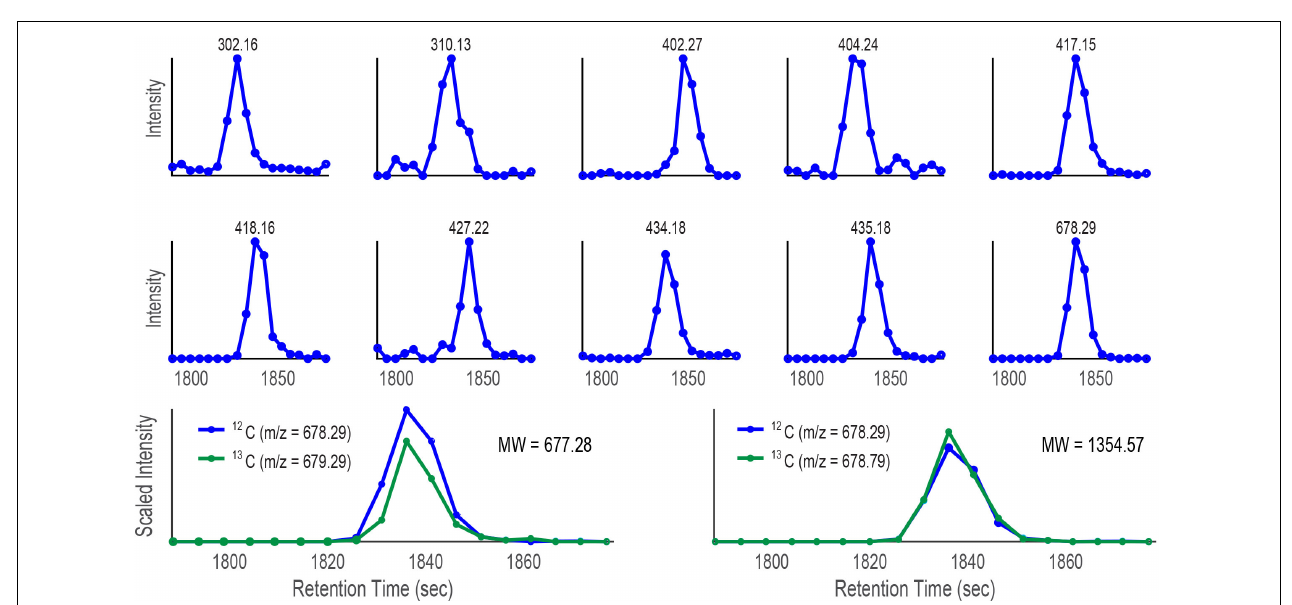
FIGURE 9 | LC-ICPMS Co-chromatograms of the SPE organic extract of Prochlorococcus MIT9215 culture media, separated with a C18 column (A) and an amide column (B) . The large peak in both chromatograms is due to the elution of the cobalamin spike. The difference in cobalamin retention time between the two separations is due to the change in selectivity of each column.